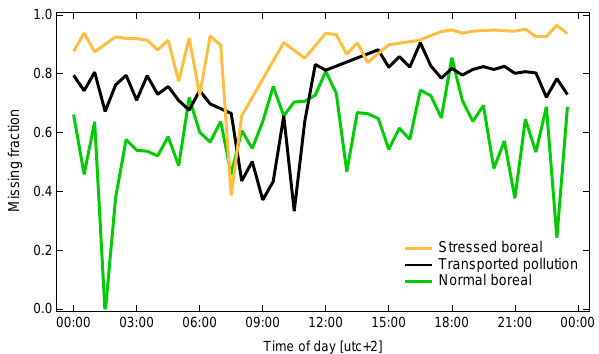
Fig. 6. Summary of missing fraction of total OH reactivity for all characteristic regimes as diel median profile: normal boreal (green), transported pollution (black), stressed boreal